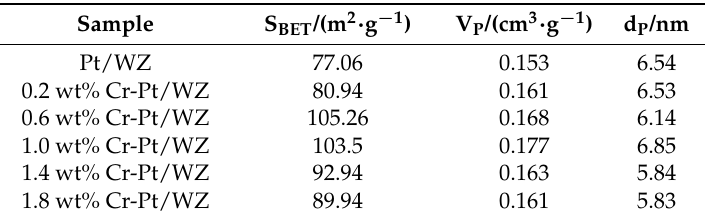
Table 1. The specific surface area and pore size and volume of the Cr-Pt/WZ catalysts with different